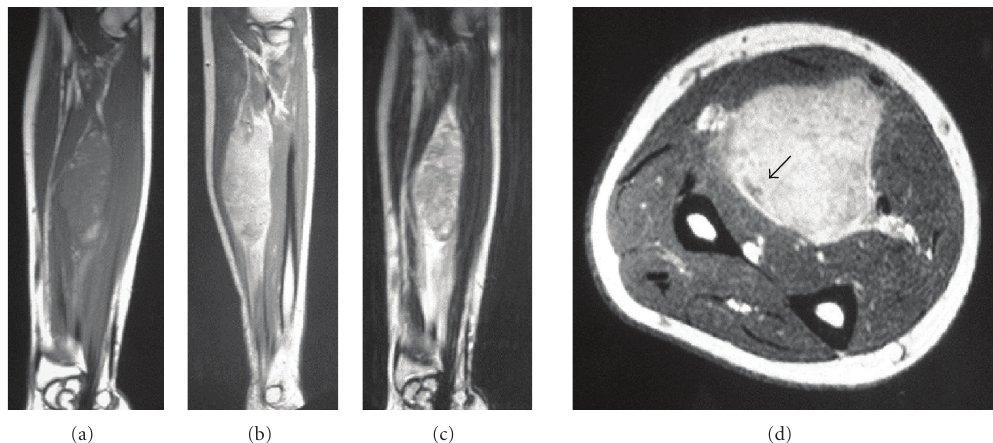
Figure 1: (a) Coronal T1-weighted, (b) T2-weighted, and (c) Gd enhanced magnetic resonance imaging shows a tumor measured approximately 8 × 4 × 3cm. (d) Tumor encircles by the flexor carpi radialis (FCR), flexor digitorum superficialis (FDS), flexor digitorum profundus (FDP), and flexor pollicis longus (FPL), and pushes aside median nerve (arrow).